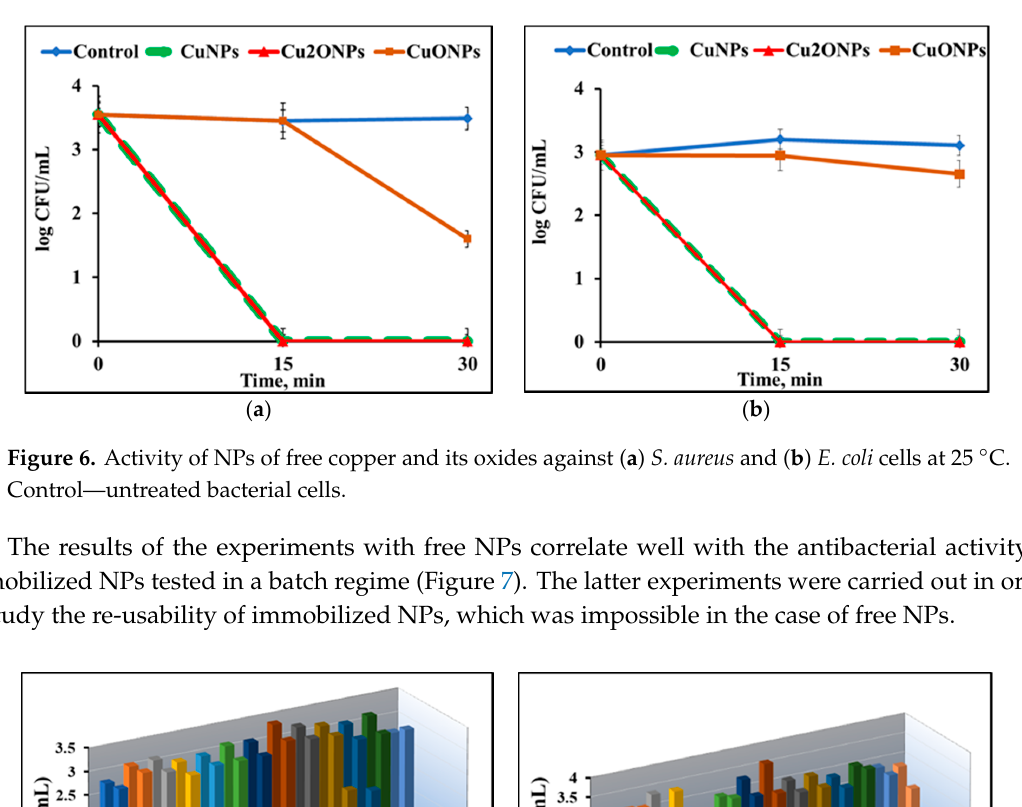
Figure 5 . Leaching of copper ions from composites of LLDPE and NPs of copper and copper oxide into bacterial suspensions of ( a ) S. aureus and ( b ) E. coli in saline in a continuous experiment. Copper concentration was measured at the inlet to the system and at the outlets from the columns with composites LLDPE/CuNPs and LLDPE/Cu 2 ONPs, and from a control column not containing composites.